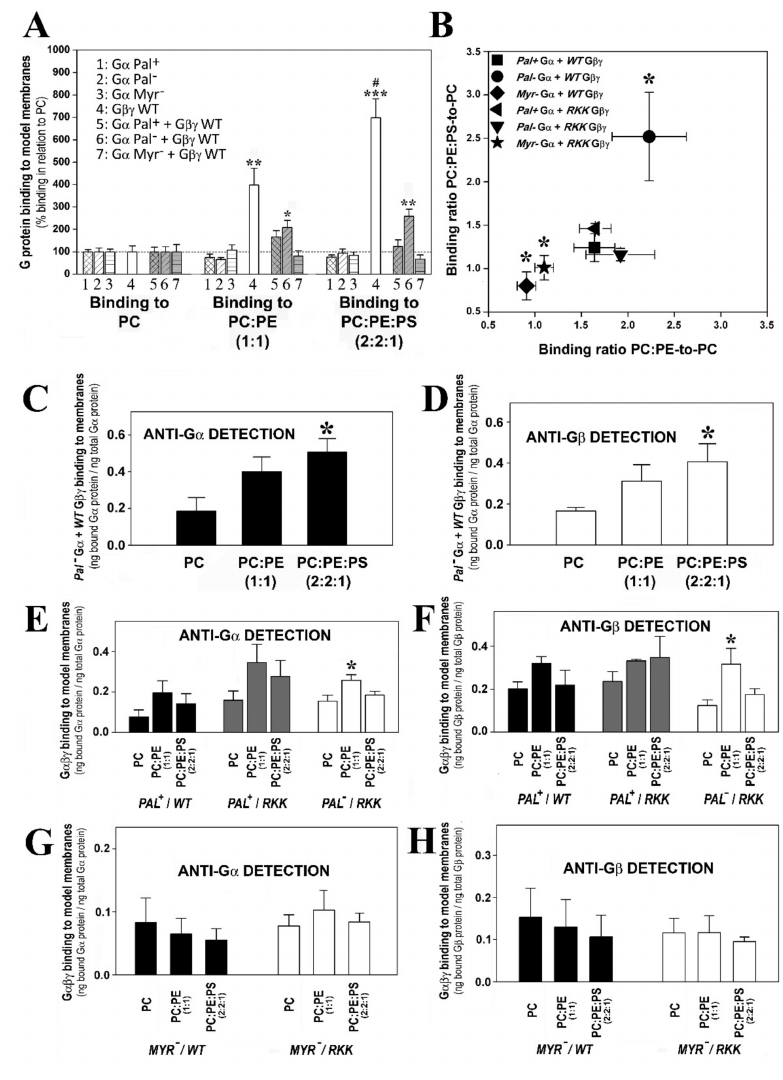
Figure 6. Effect of the major P-face membrane lipids, PS and PE and G α i 1 /G γ 2 structure on the G αβγ -membrane interactions. ( A ), Graph of the global G protein–membrane interactions. Binding